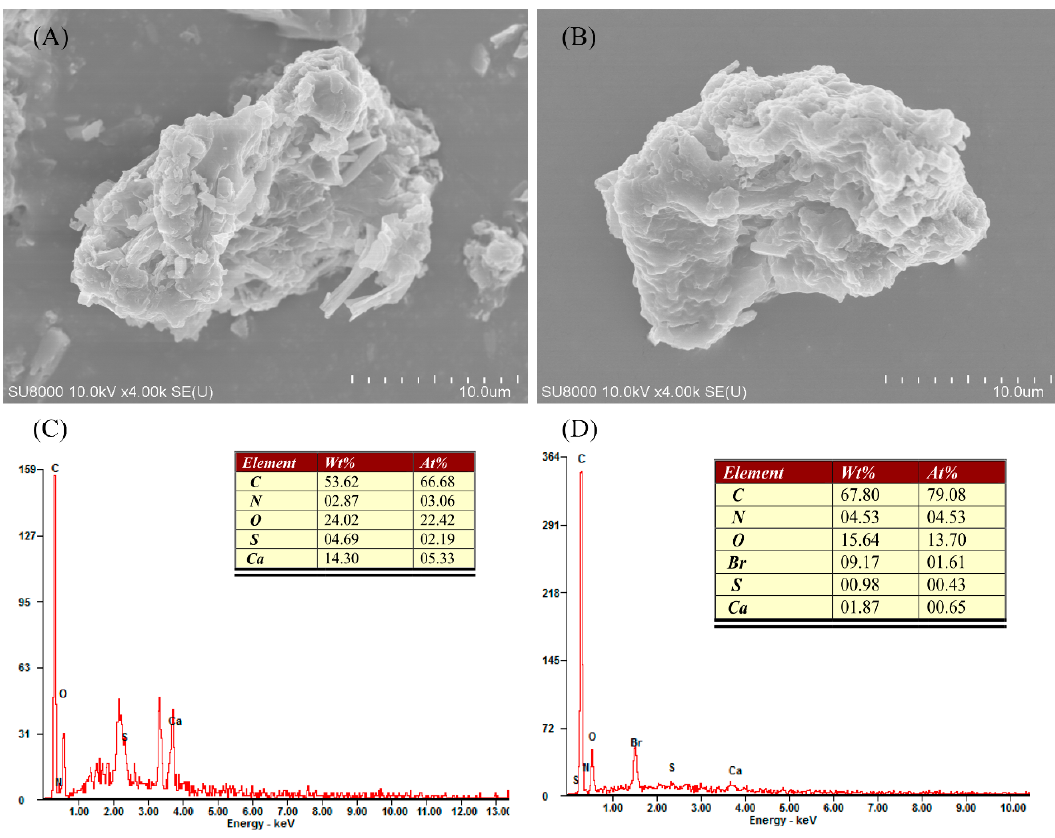
Figure 2. SEM and EDX analysis of SMW ( A , C ); and SMWC ( B , D ).